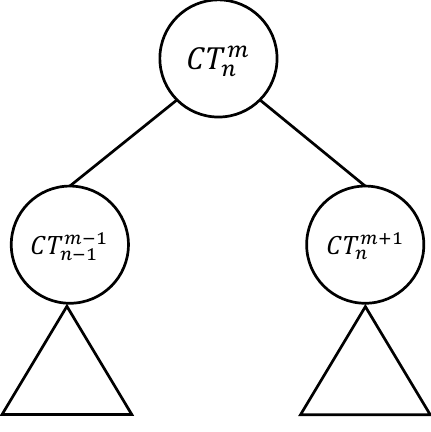
Figure 5. An AND/OR tree for CT m n